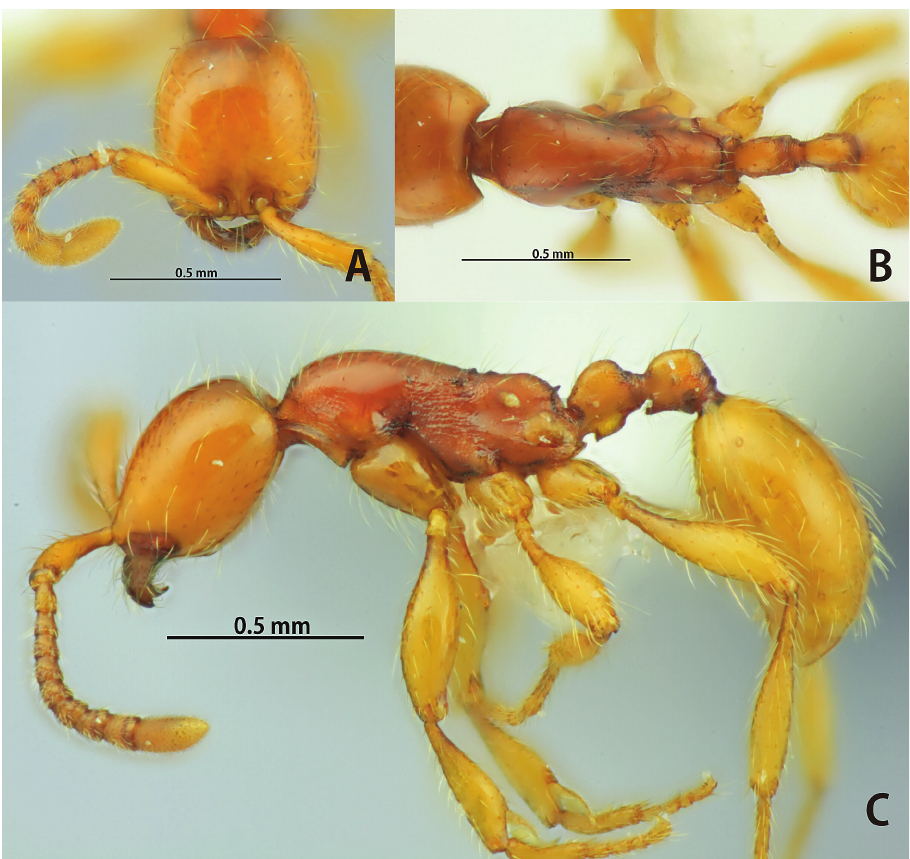
Figure 6. Aenictus eguchii (paratype). A Head in full-face view B body in dorsal view C body in